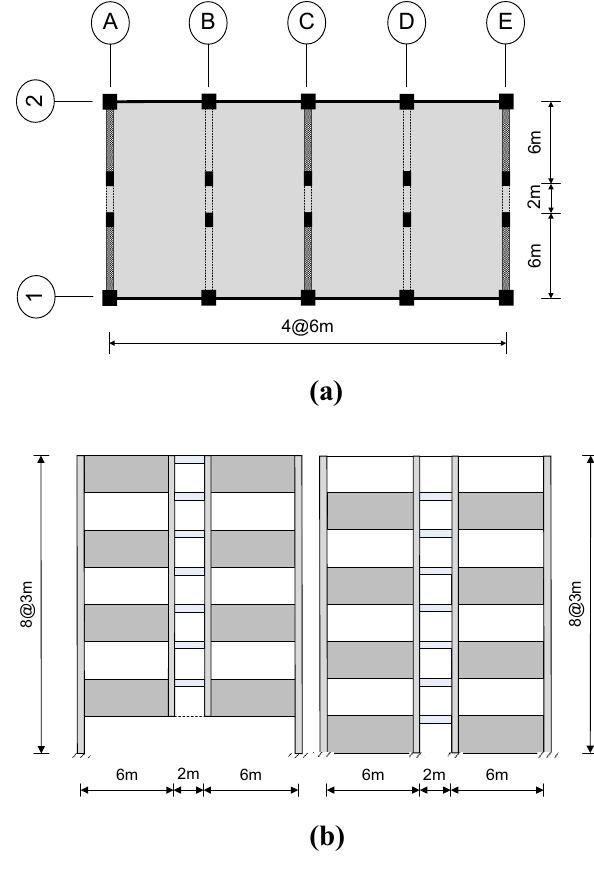
Fig. 17 Analysis model structure with interior columns. a Structural plan and b structural